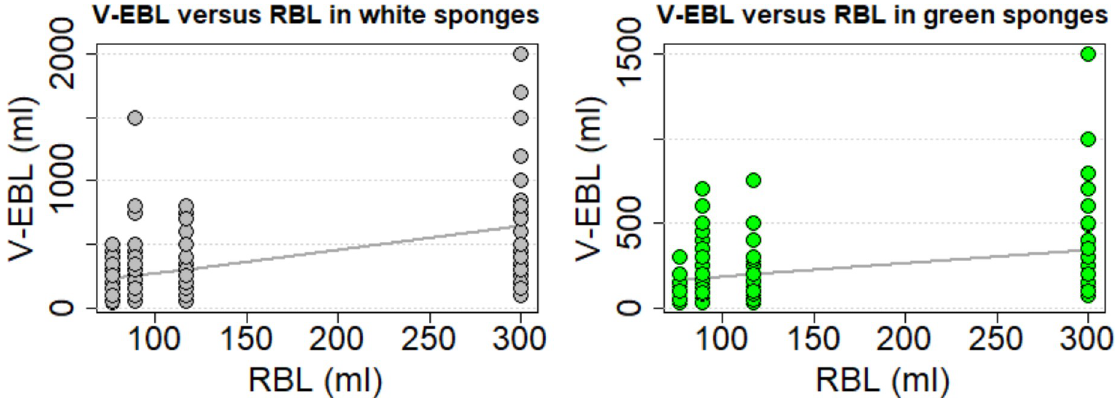
Fig 3. Scatter plots with corresponding regression lines in white and green sponges. Scatter plots for visually estimated blood loss (V-EBL) for white and green sponges and corresponding univariate linear regression line depending on reference blood loss (RBL).